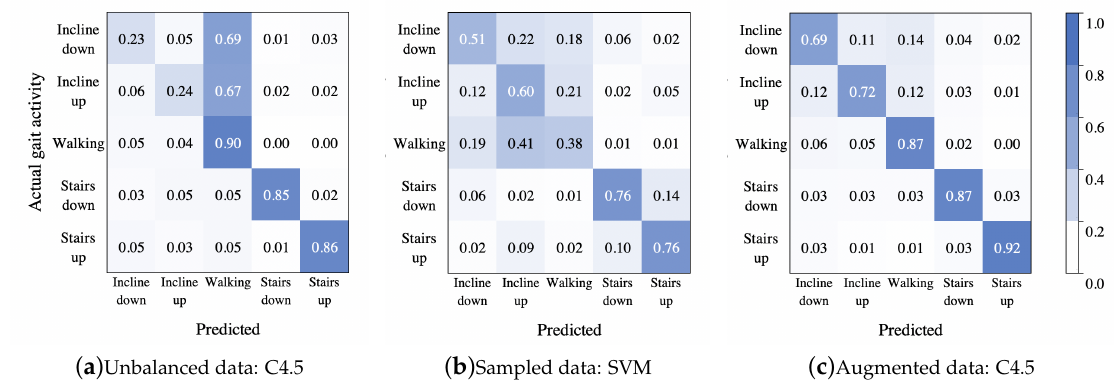
Figure 7. Confusion matrices for the best treatment by each classifier using unbalanced data from Table 2: C4.5 with features Acc FD + Gyr FD ( a ), sampled data from Table 4: SVM with all features ( b ), and augmented data from Table 6: C4.5 with all features ( c ).